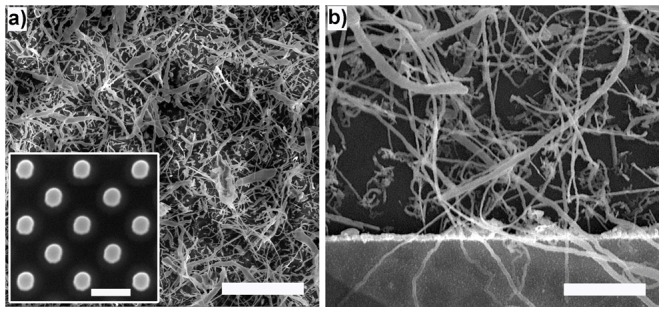
Device Fabrication.(a) SEM image of complex Ag networks (scale bar = 10 µm) produced by reaction of aqueous AgNO3 (50 mM) with (inset) lithographically patterned Cu seed posts (scale bar = 1 µm). (b) High resolution image of the functionalized Ag network at the device electrode interface (Pt) showing wire widths ranging from 100 nm to 3 µm (average <1 µm) and lengths extending from a few microns to almost a millimeter (scale bar = 700 nm).